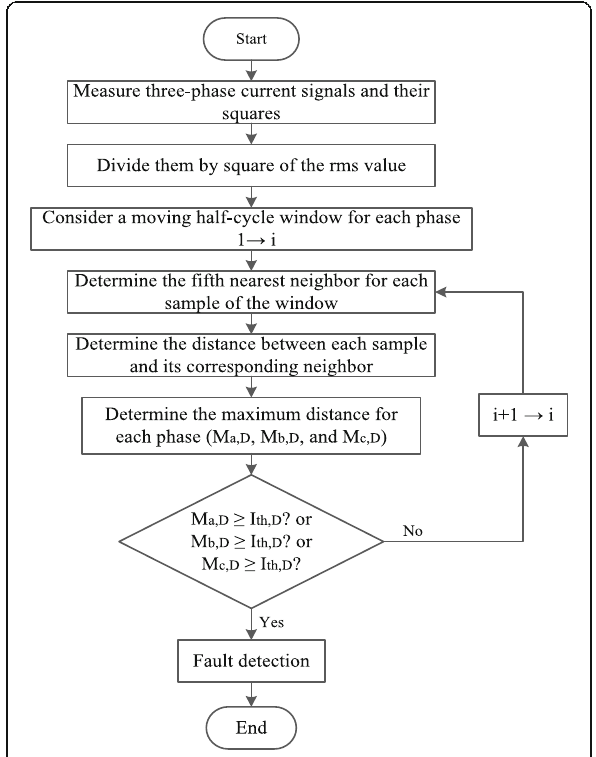
Fig. 2 The proposed change detection